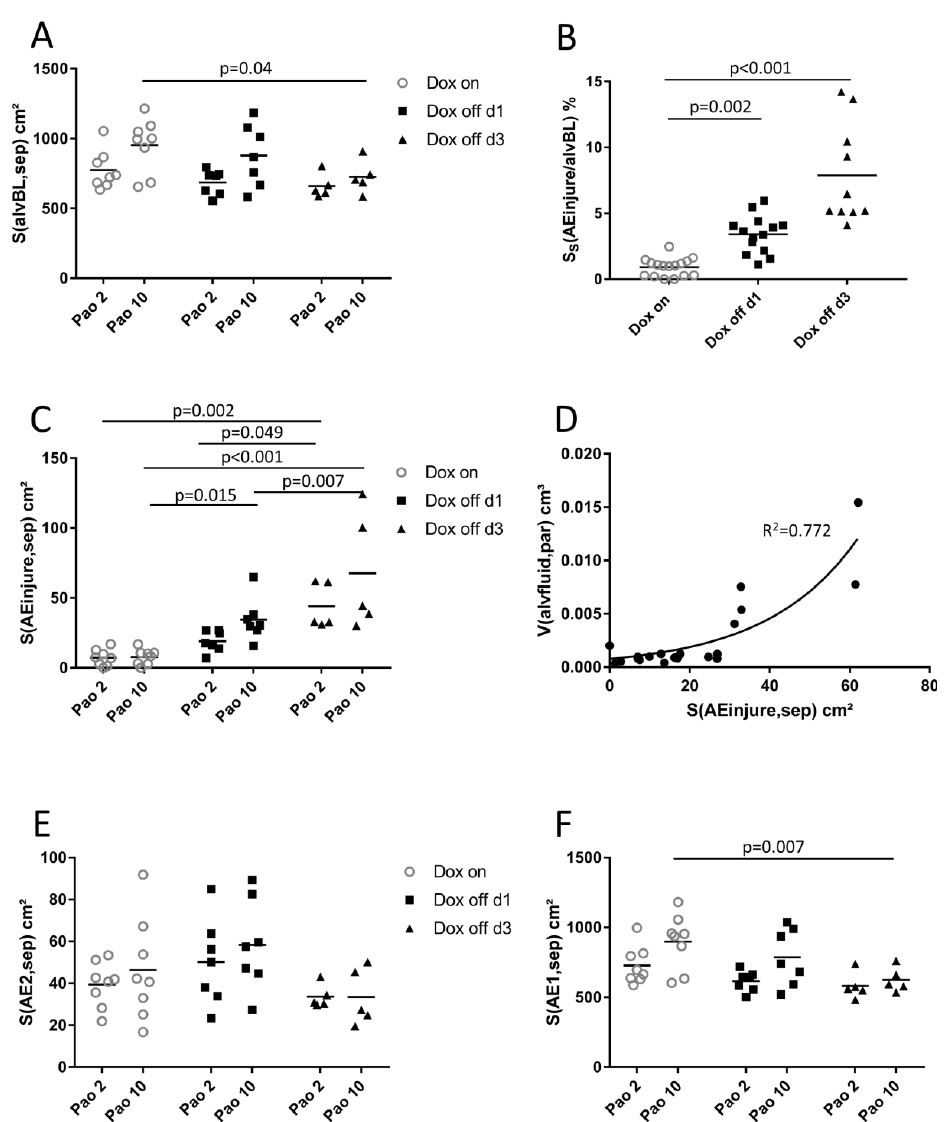
Figure 7. Stereological parameters of alveolar epithelial cell injury. Data were related to the total surface area of the alveolar epithelial basal lamina within septal walls ( A ) S(alvBL,sep). In ( B ), the surface fraction of the basal lamina covered by injured alveolar epithelial cells S S (AEinjure/alvBL) shows an increase in Dox off d1 and Dox off d3. Multiplication of the surface fraction and S(alvBL,sep) resulted in absolute surface areas within the septal walls of injured alveolar epithelial cells ( C ), normal appearing alveolar epithelial type 2 ( E ) and alveolar epithelial type 1 ( F ) cells. ( D ) demonstrates the relationship between the total surface area of injured alveolar epithelial cells S(AEinjure,sep) and the total volume of alveolar fluid V(alvfluid,par) which can be described by an exponential growth function.